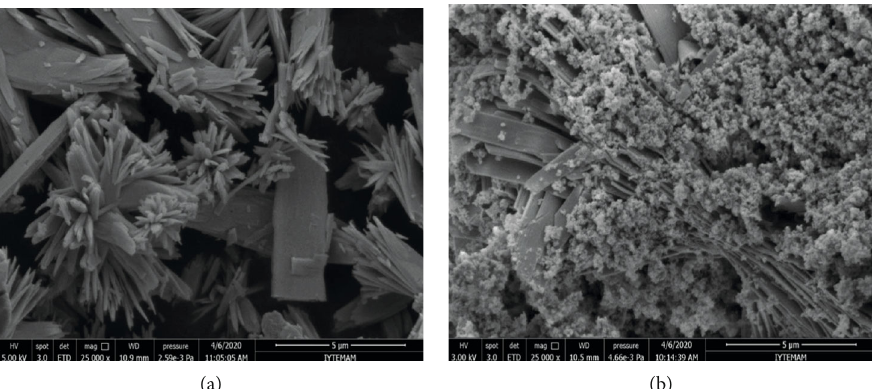
Figure 4: SEM image of the representative samples prepared in the presence of 50ppm (a) Gelatin and (b) PVP. The magni fi cation is 25000x.